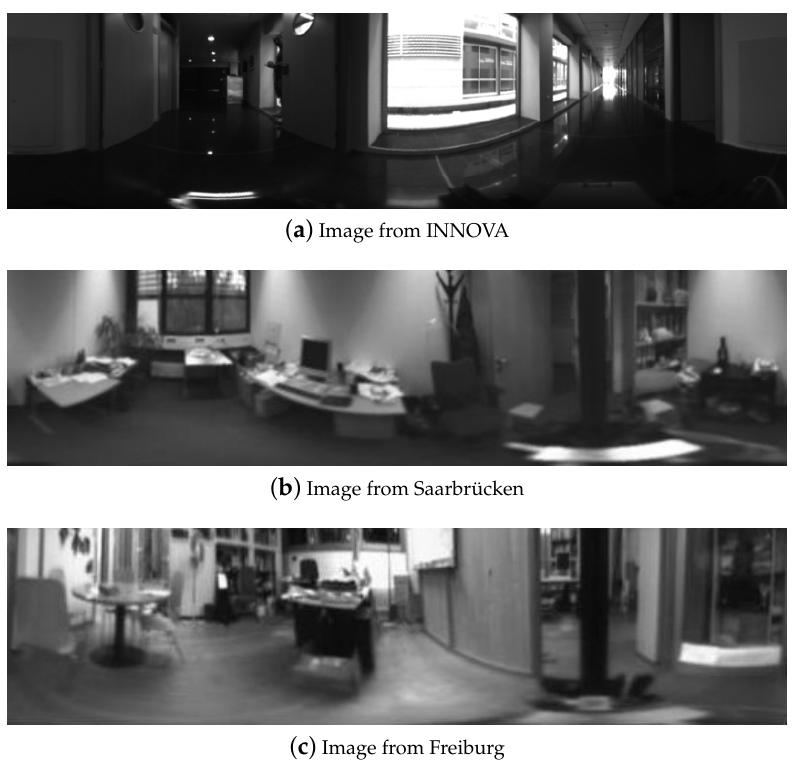
Figure 7. Mobile robot and its vision system in INNOVA dataset [22].